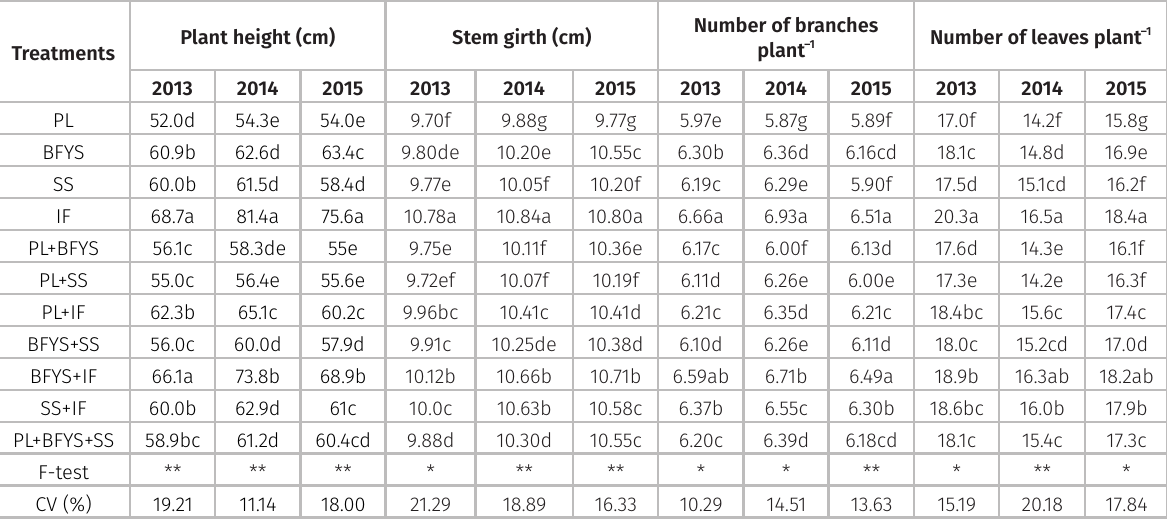
Table IV. Yield components of forage soybean as influenced by different mineral and organic fertilization regimes under irrigated conditions of Faisalabad,